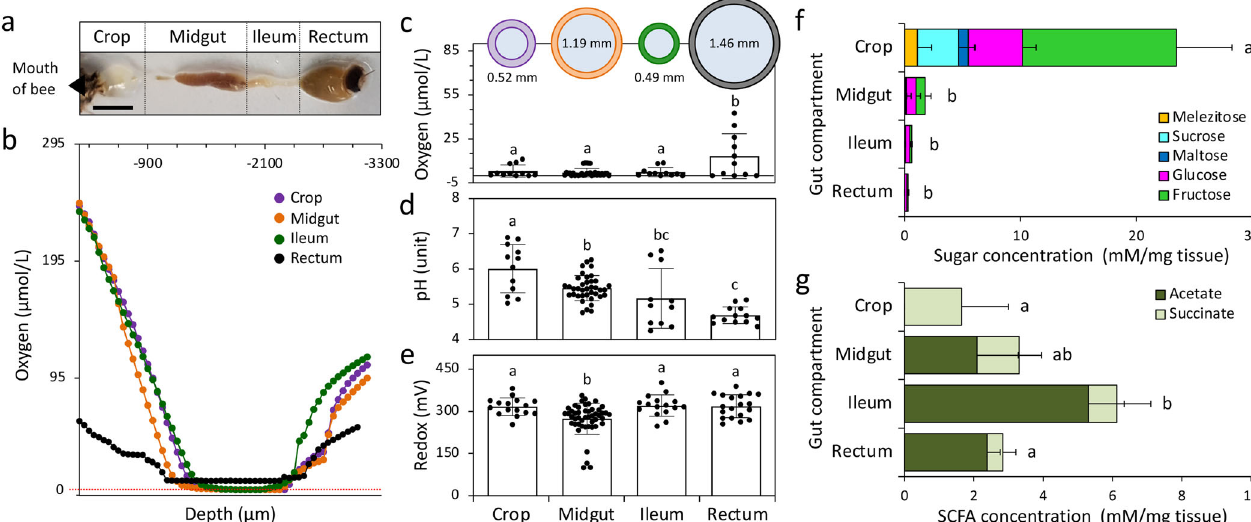
Fig. 5 Physico-chemical and metabolite characterization of the honeybee gut compartments. a Honeybee gut compartments (the crop, midgut, ileum, and rectum) are depicted (bar = 0.5 cm). b – e Physico-chemical parameters measured by microsensors are reported for each gut compartment. b Representative radial pro fi le of the oxygen concentration ( μ mol/l) along the gut compartments (i.e., the crop, midgut, ileum, and rectum) of honeybees. Depth refers to the distance covered by the electrode tip starting from the agarose surface (details in “ Materials and methods ” ). c Schematic representation of the diameters of the gut compartments (circles at the top of the panel); diameters were expressed in mm, and their mean ± standard deviation ( n = 12) are indicated by the internal and external circles, respectively. Details on the organ diameters are reported in Supplementary Table S12. The oxygen concentration measured in the central regions of the gut compartments ( n = 11) are expressed as μ mol/l. Microelectrode pro fi les of the ( d ) pH and ( e ) redox potential along the honeybee gut compartments ( n = 12 and n = 16, respectively); values are expressed as unit and mV, respectively. Concentration (mM/mg of tissue) of ( f ) sugars and ( g ) short-chain fatty acids (SCFAs) in the gut compartments ( n = 3); values are expressed as mean ± standard deviation. Letters show the results of Tukey ’ s multiple comparison test. Italian A. mellifera ligustica forager bees were considered for physico-chemical and metabolite